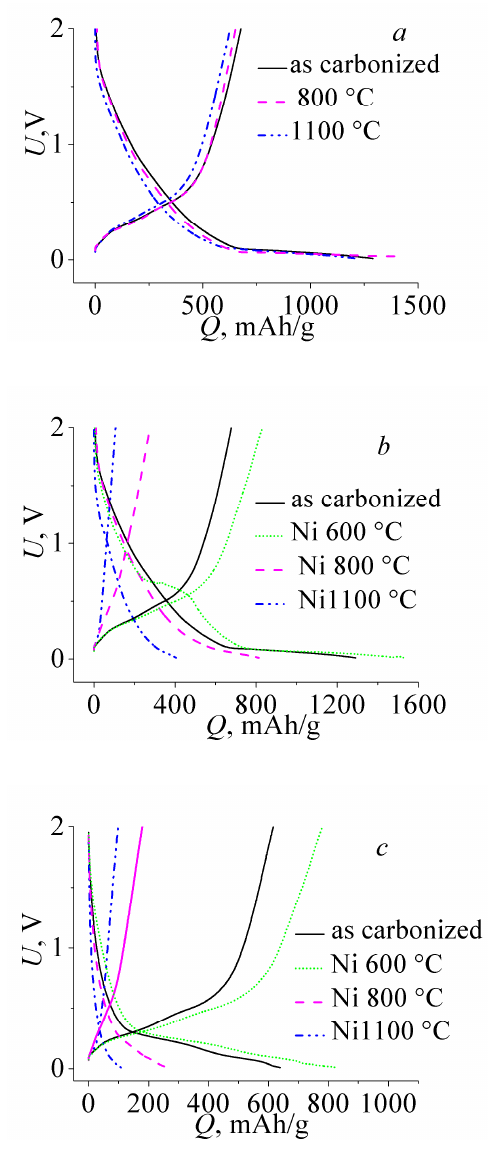
Figure 11. Voltage profiles of the first ( a , b ) and fifth ( c ) cycles for samples annealed at different temperatures.